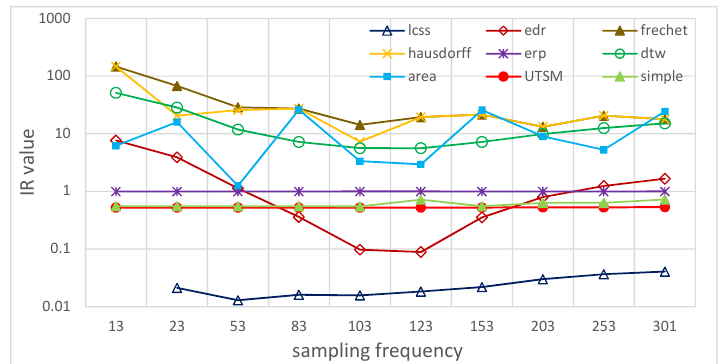
Figure 18. IR of asynchronous sampling